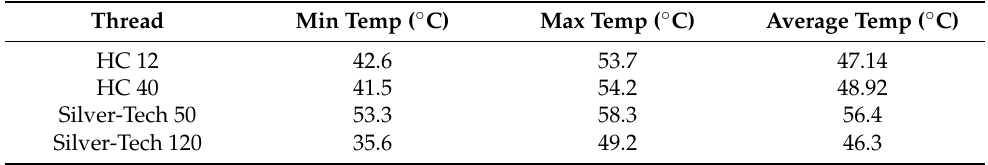
Table 5. Temperatures recorded per thread type at the time of